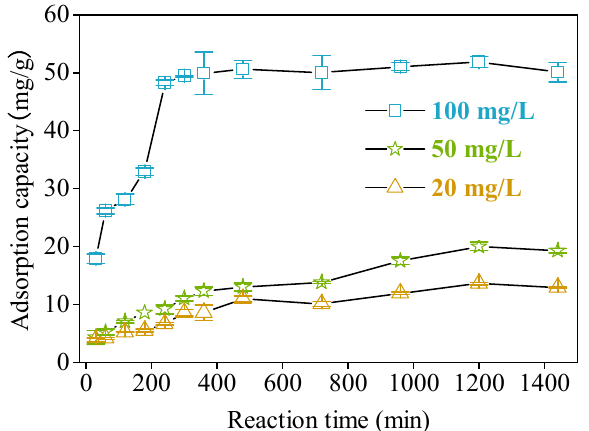
Figure 5. The adsorption capacity of Cr(VI) by Mxene–CS (0.6 g/L) with varying initial Cr(VI) concentration (Conditions: Adsorption temperature of 25 °C and pH of 4.3).